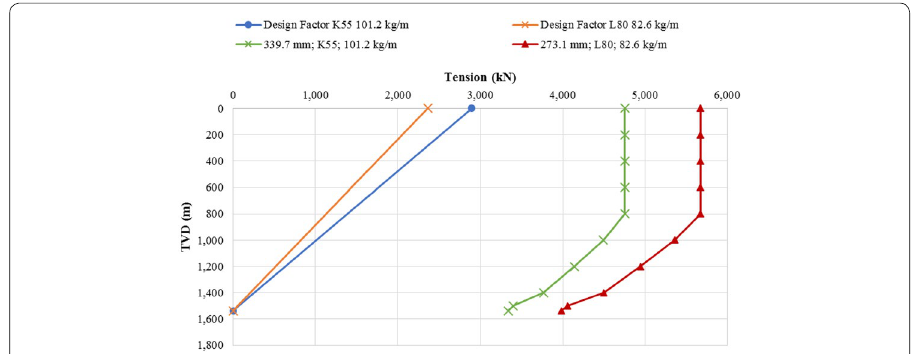
Fig. 10 Tension load for production casing and tieback casing of well